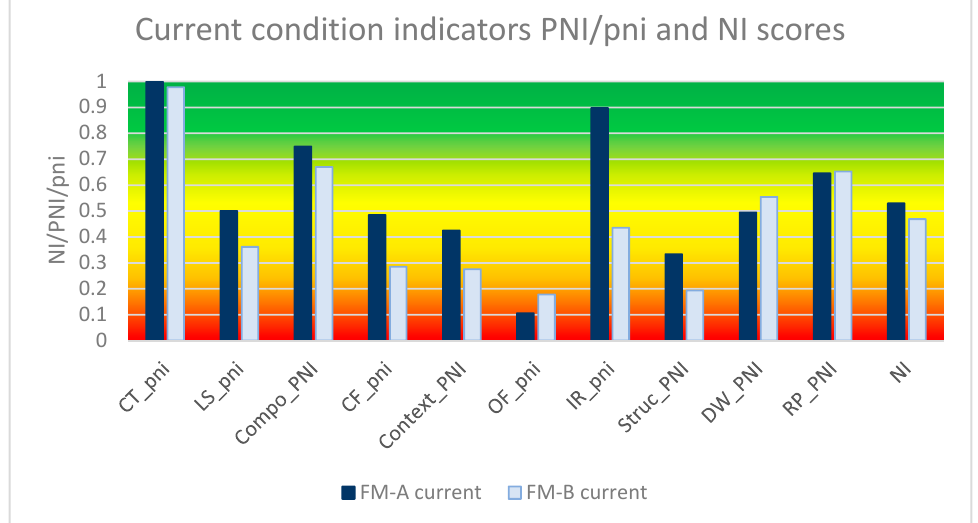
Figure 1. Results for condition indicators and naturalness for FM-A and FM-B. PNI: partial